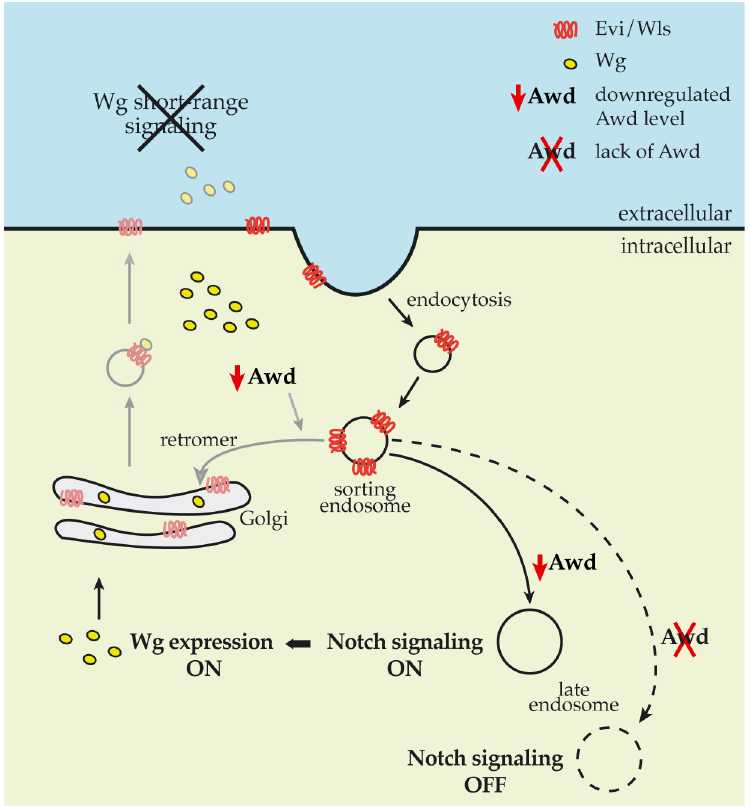
Figure 6. Impact of Awd levels on Notch and Wg signaling pathways. Schematic showing the impact of reduced (solid lines) and null (dashed line) Awd levels in cells at the DV boundary of wing disc. Grey lines show working hypothesis on the Awd involvement in recycling back the Evi chaperonin.